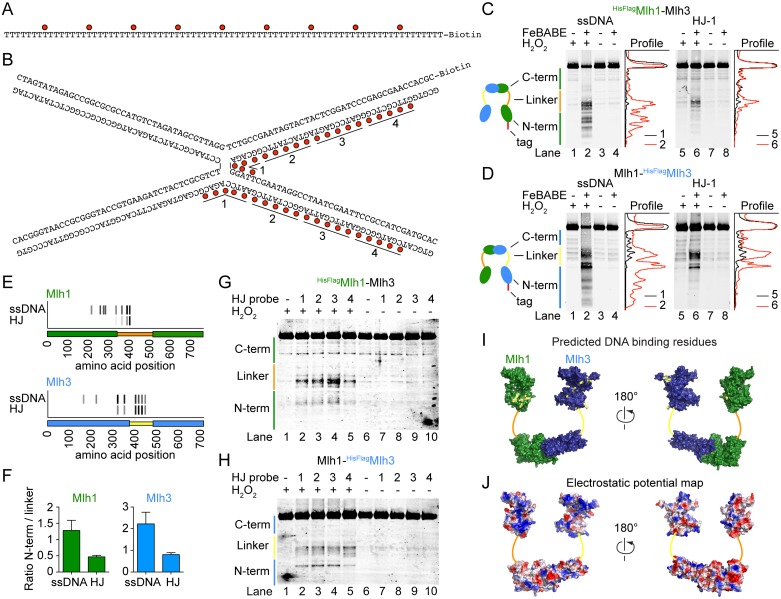
Mapping the DNA-binding interfaces of MutLγ by hydroxyl radical footprinting.A, B. Sequences of ssDNA (A) and HJ (B) substrates highlighting the positions of the FeBABE moieties (red dots). HJ substrates were labeled on two strands within the numbered segments: labeling in segments 1 was used for the cleavage experiments in panels C and D; HJ substrate labeled in segments 1–4 were used in panels G and H. C. Hydroxyl radical cleavage of HisFlagMlh1-Mlh3 with FeBABE-labeled ssDNA (left) or HJ (right). Mlh1 cleavage fragments were detected by anti-Flag western blotting. Traces of individual lanes are shown. Experiments were done at least 3 times with comparable results. D. Hydroxyl radical cleavage of Mlh1-HisFlagMlh3 with FeBABE-labeled ssDNA (left) or HJ (right). Mlh3 cleavage fragments were detected by anti-Flag western blotting. E. Summary of the hydroxyl radical cleavage results. For each cleavage fragment of Mlh1 (top) and Mlh3 (bottom), a short stretch of amino acids in the vicinity of the predicted DNA-binding residues is indicated by a gray tick mark that is shaded in proportion to the intensity of the hydroxyl radical cleavage signal detected with each DNA substrate. The protein domains are cartooned along the horizontal axes: orange (Mlh1) or yellow (Mlh3) for linker regions; green for N- and C-terminal domains of Mlh1; and blue for N- and C-terminal domains of Mlh3. F. The ratio of cleavage fragment intensities mapping to the N-terminal domains and linkers of Mlh1 and Mlh3 with the ssDNA and HJ substrates. Error bars are standard deviations of three independent experiments. G, H. Effect of changing the position of the FeBABE moiety along the HJ substrate. (G) HisFlagMlh1-Mlh3 and (H) Mlh1-HisFlagMlh3. I. The positions of FeBABE-predicted DNA-binding residues are highlighted in yellow on a homology-based model of the Mlh1-Mlh3 heterodimer. J. Electrostatic potential map of the Mlh1-Mlh3 model.